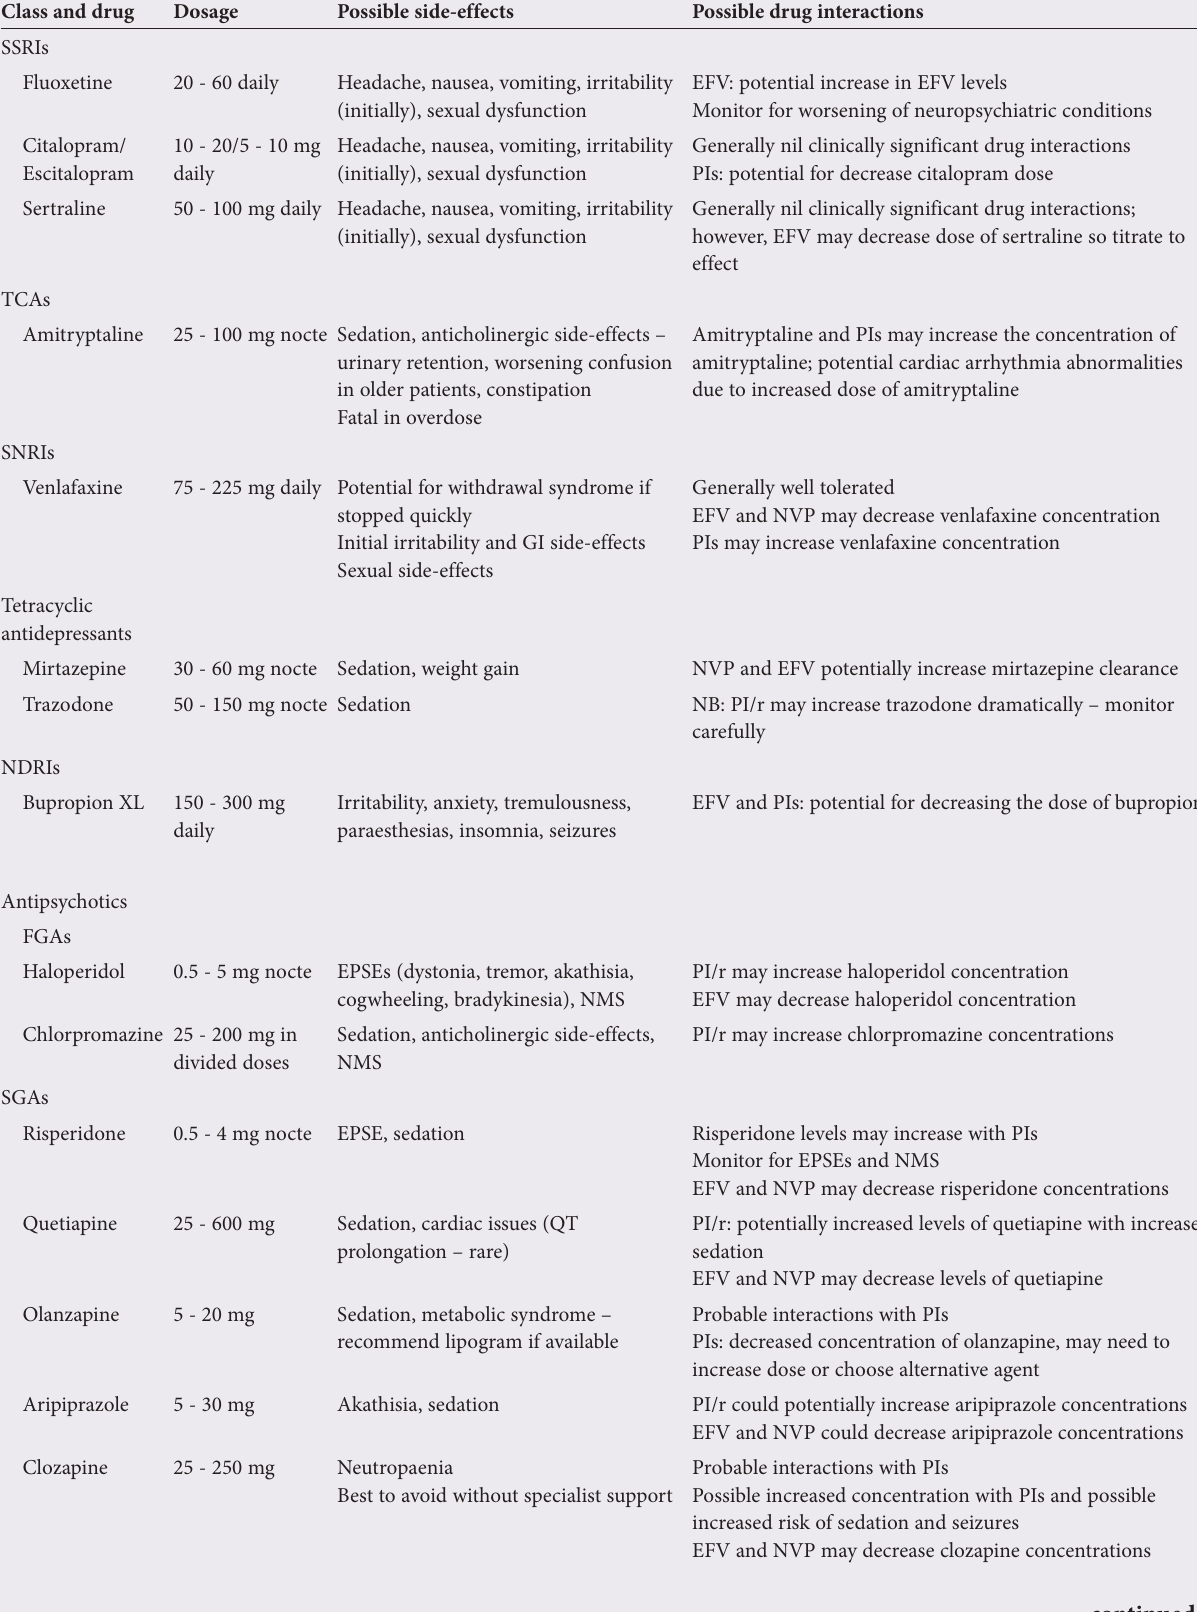
Table 2. Commonly used drugs and their interactions [19,20] * Class and